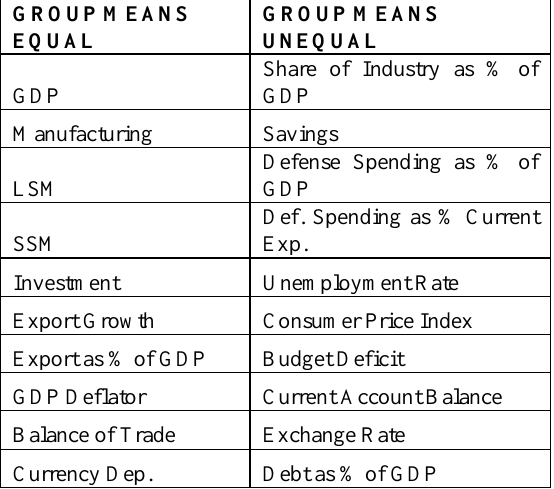
TABLE 3: Summary of Analysis for T-Test and